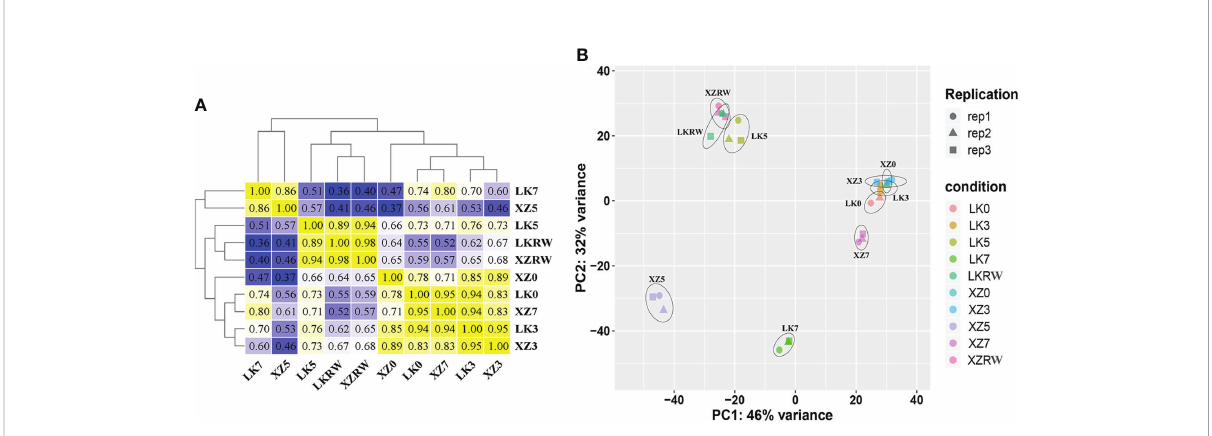
FIGURE 3 Pearson correlation (A) and principal component analyses (B) of RNA-seq data from fi ve time points of drought treatment in XZSN and LK3. LK0, LK3, LK5, LK7, and LKRW represent genotype LK3 being subjected to natural drought stress conditions by withholding water for 0, 3, 5, and 7 days and rewatering treatment for 2 days, respectively. XZ0, XZ3, XZ5, XZ7, and XZRW represent genotype XZSN being subjected to natural drought stress conditions by withholding water for 0, 3, 5, and 7 days and rewatering treatment for 2 days,